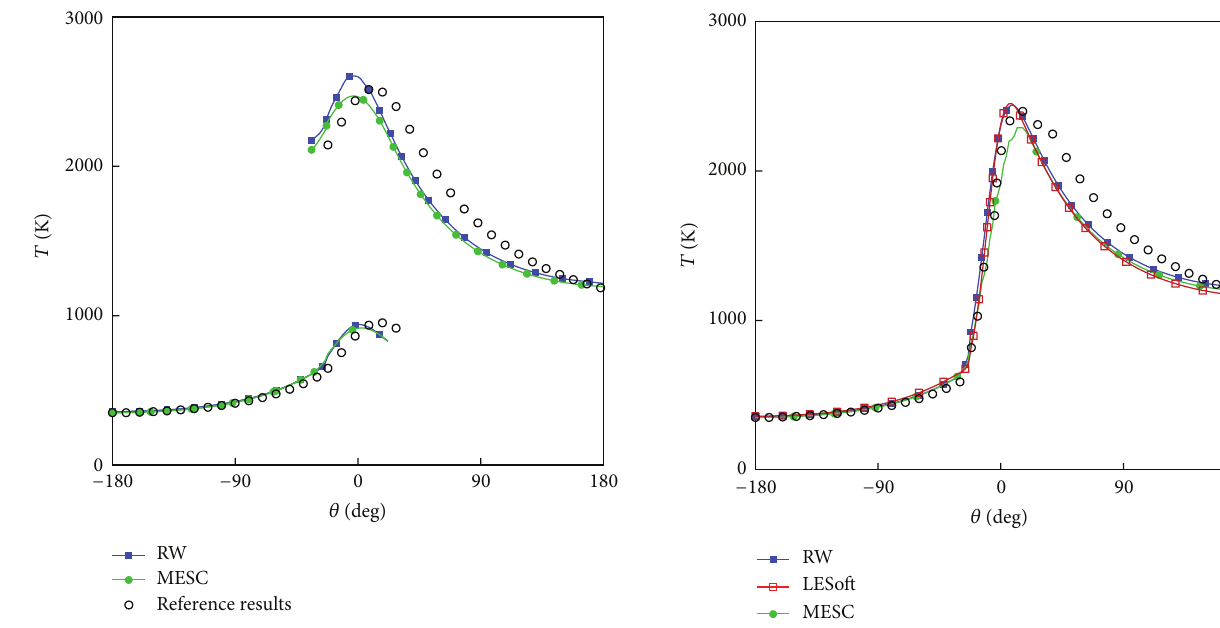
Figure 9: Comparison of unburned and burned temperature profiles with reference data of [23]. Figure 10: Comparison of averaged temperature profiles with reference data of [23].